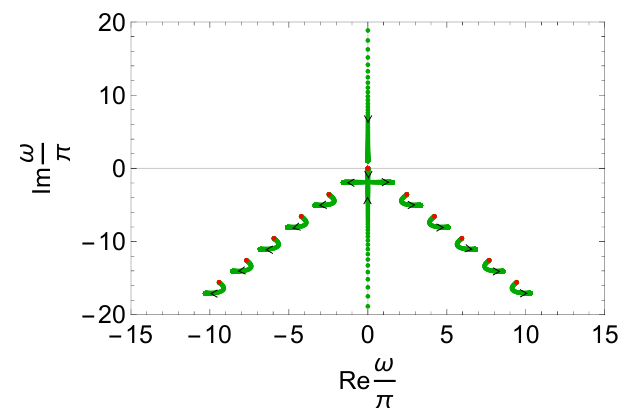
Figure 3. Homogeneous quasinormal modes with arrows indicating the direction of increasing cou- pling, β . Red points denote the β = 0 case, which is the typical "Christmas tree" pattern of the QNMs. A collision of poles indicates the breaking of the softly broken global symmetry.